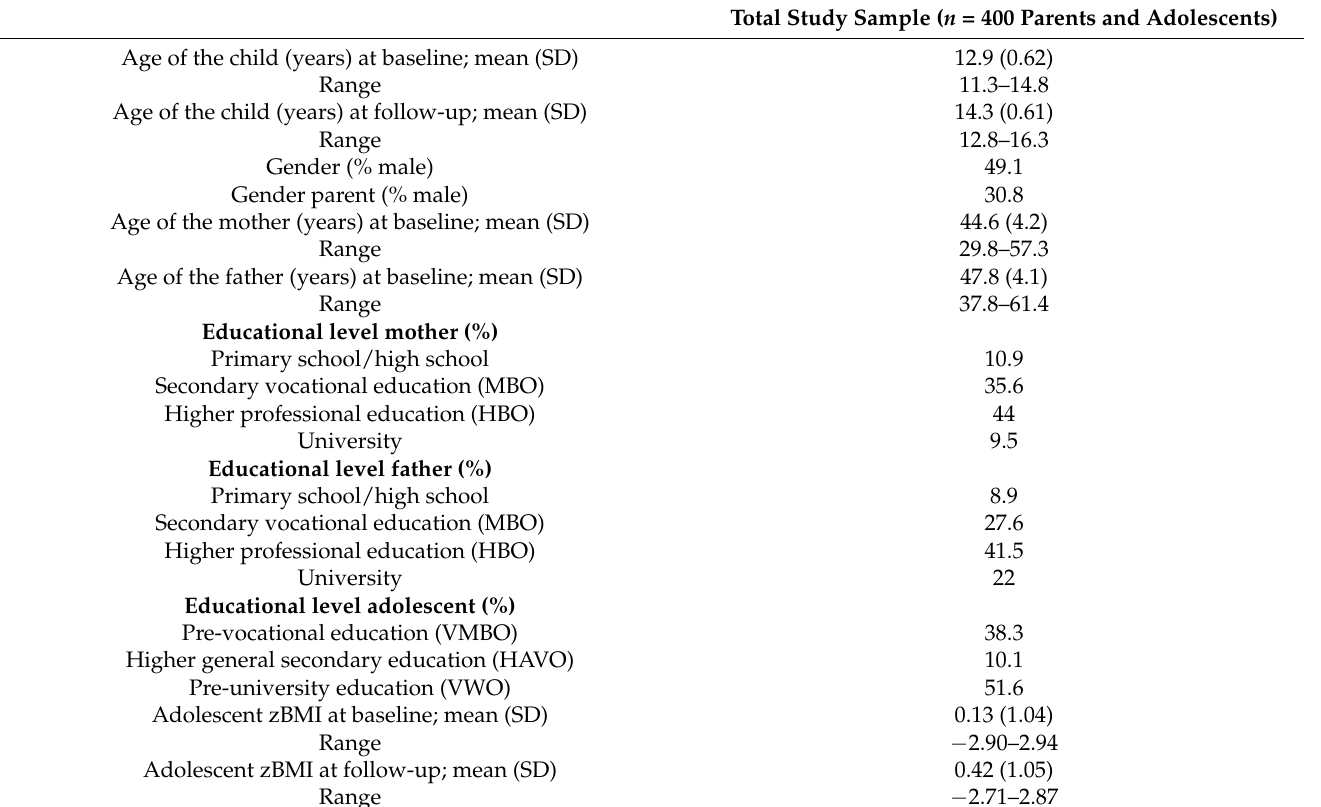
Table 1. Socio-demographic characteristics of the study